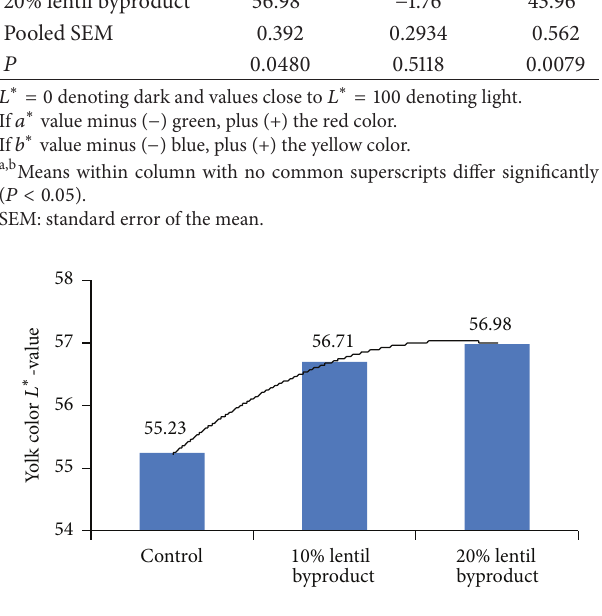
Figure 4: Effect of lentil byproduct on yolk color 𝐿 ∗ value, 𝐿 ∗ = 0 denoting dark and values close to 𝐿 ∗ = 100 denoting light.